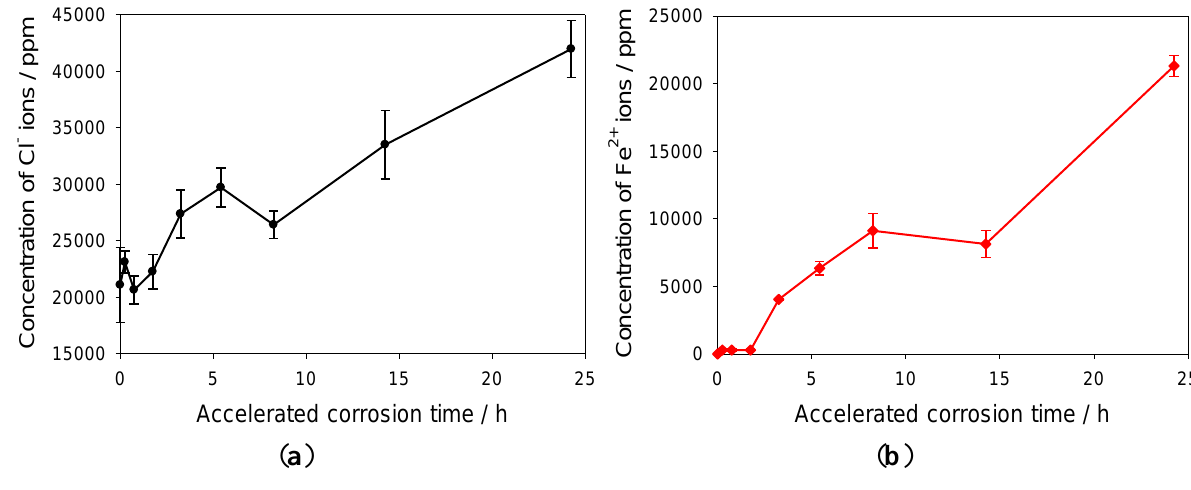
Figure 6. Concentration profiles of ( a ) chloride; and ( b ) ferrous ions as a function